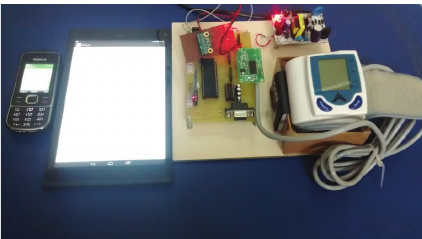
Figure 3: Hardware setup (BSU, microcontroller development board, Tablet PC, and mobile phone).